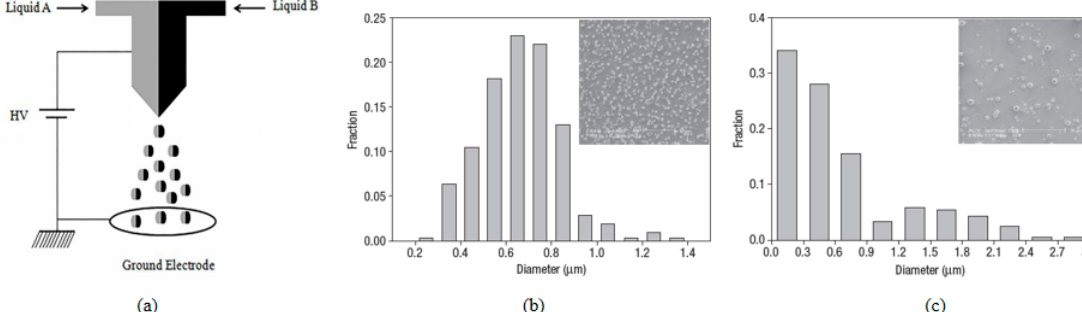
Figure 8. ( a ) Schematic image of the electrohydrodynamic co-jetting process yielding bicompartmental spherical, discoid, and rod-shaped microparticles; ( b ) Size distributions of polyethylene oxide (PEO); and ( c ), polyacrylic acid (PAA) biphasic particles determined from the SEM images (Adapted from [92]).